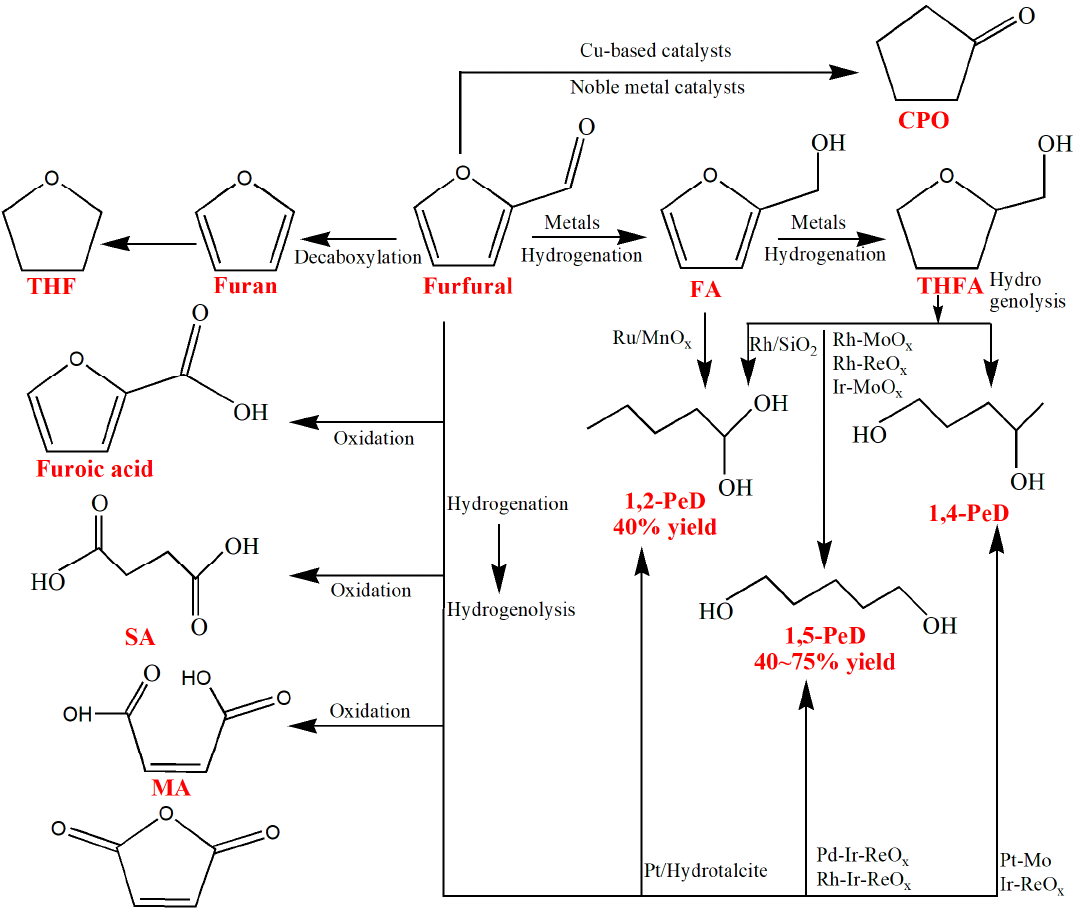
Figure 10. Catalytic conversion of furfural to chemicals [FA: furfuryl alcohol; THFA: tetrahydrofurfuryl alcohol; CPO: cyclopentanone; 1,2-PeD: 1,2-pentanediol; 1,4-PeD: 1,4-pentanediol; 1,5-PeD: 1,5-pentanediol; THF: Tetrahydrofuran; SA: Succinic acid; MA: Maleic acid; and MAN: Maleic anhydride].